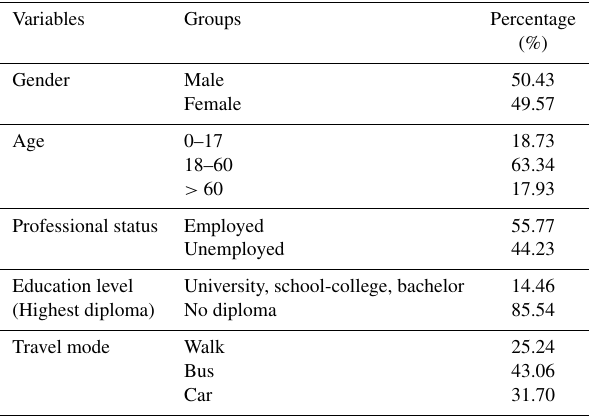
Figure 7. Spatial distribution of blocks. Table 4. Sociodemographic characteristics of the study area popu-